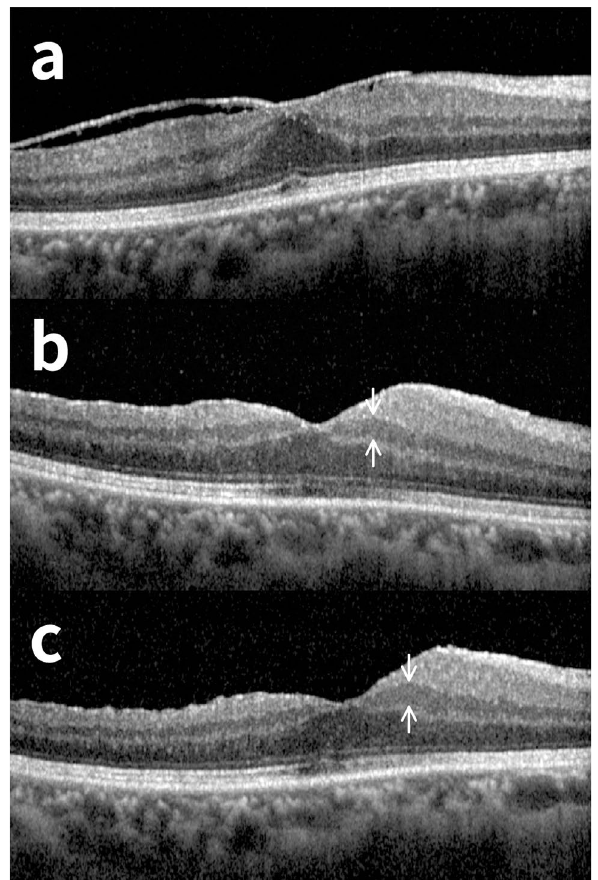
Figure 2. A representative case of nasal inner nuclear layer (INL) thickening patient after epiretinal membrane (ERM) surgery. A 48-year-old female with ERM had metamorphopsia and she underwent surgical peeling of ERM on her right eye. Combined cataract surgery and internal limiting membrane peeling were performed together. ( a ) Preoperative optical coherence tomography (OCT) image. ( b ) OCT images taken 38 days after the surgery. The thickness of nasal INL had increased after the surgery. ( c ) At last visit (580 days after the surgery), the nasal INL had remained thickened, best corrected visual acuity remained the same (20/25 for both preoperatively and postoperatively), and subjective metamorphopsia had not been improved. The distance between fovea and disc decreased after the removal of